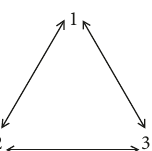
Figure 1: Interaction graph for the 3 agents of Examples 1, 2, and 3.